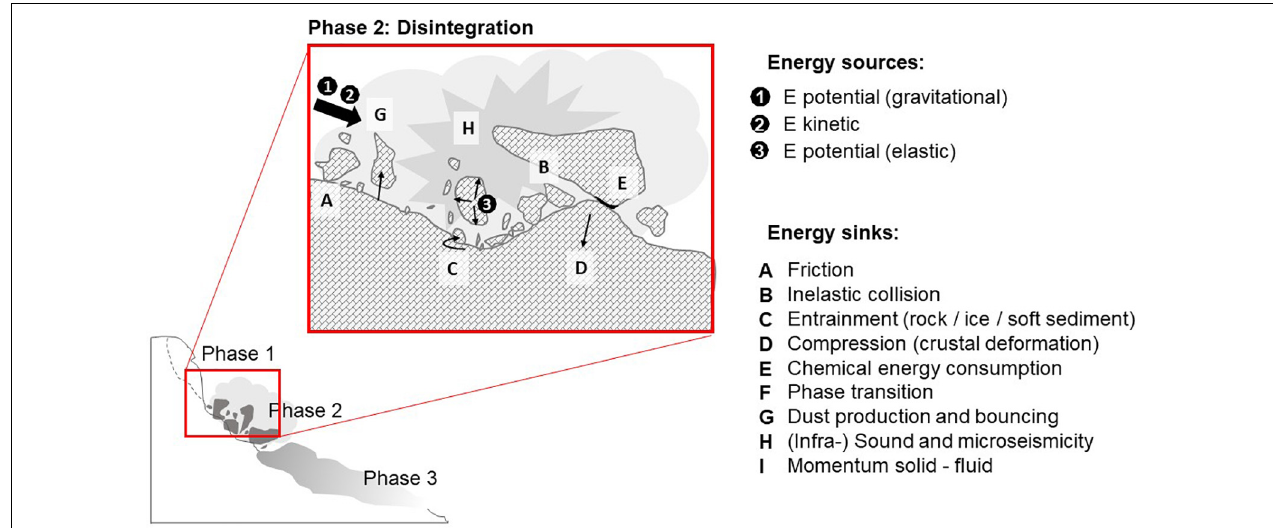
FIGURE 1 | Energy dissipation in Rock Avalanche Phase 2 (Disintegration). The primary energy input to the system is mostly derived from the potential/kinetic energy of the moving rock mass (“Energy sources”). “Energy sinks” cover different types of energy transformation, the majority of which involve heating. ( A) Friction . ( B) Inelastic collision : breaking at bonds stretching and friction. ( C) Entrainment : plowing, scouring. ( D) Compression: crustal deformation. ( E) Chemical energy consumption : e.g., mineral transformation. (F) Phase transition: solid – fluid – gas, needs latent energy. ( G) Dust production and bouncing . ( H) Sound and microseismicity. (I) Momentum exchange between solid and fluid phase : energy dissipates to shock wave. The sediment record theoretically shows transitions linked to ( A)–(F) . ( F) and ( I) may be present, but cannot be illustrated in the figure. Small arrows indicate direction of energy